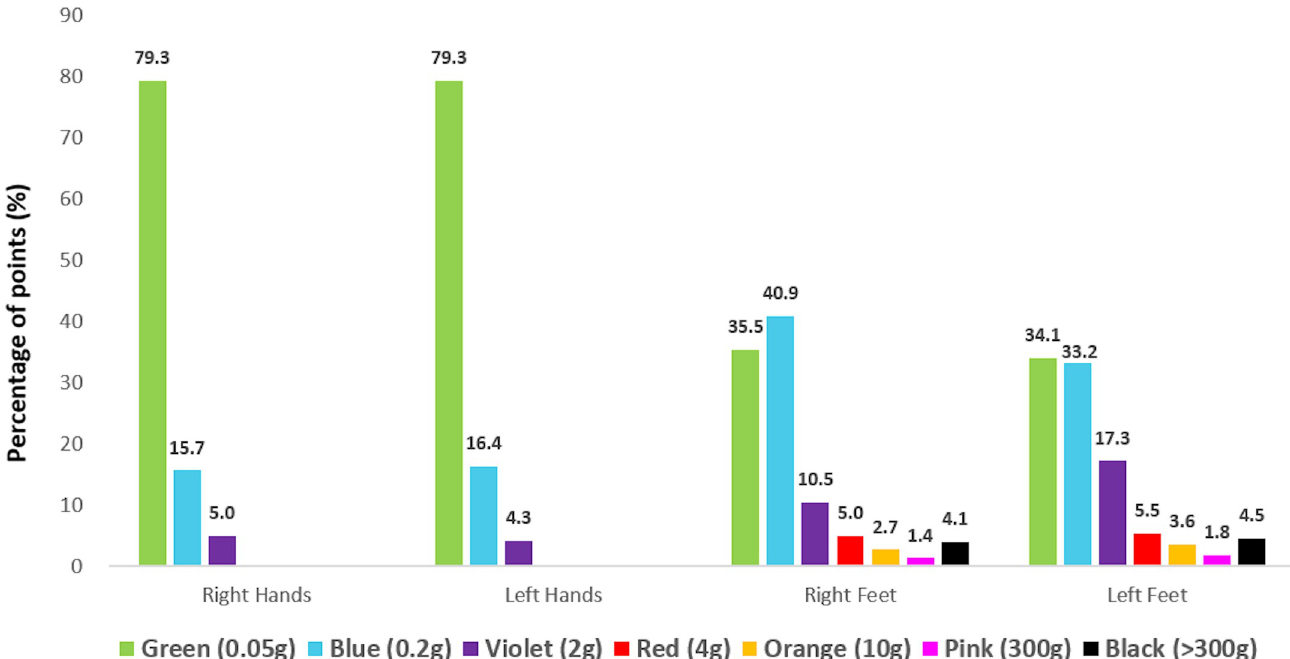
Fig 5. Distribution of the percentage of numbers of esthesiometric points tested on the right and left hands and feet at the diagnosis of leprosy patients in the Female Prison of Ribeir ã o Preto, Brazil.